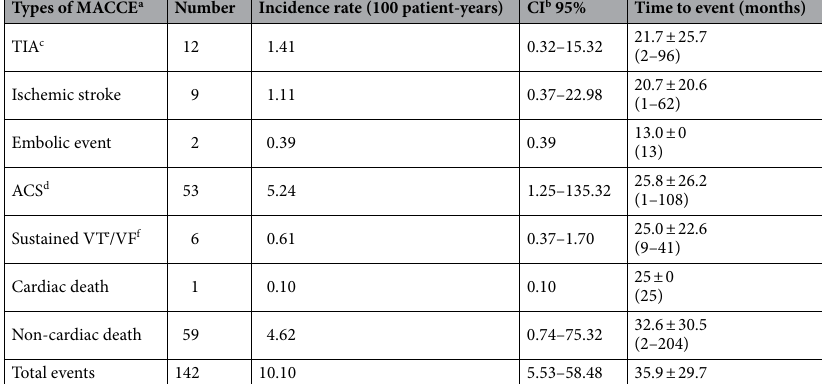
Table 2. Types and incidences of major adverse cardio/cerebrovascular events. Data are presented as mean ± SD or n. a MACCE major adverse cardio/cerebrovascular events. b CI confidence intervals. c TIA transient ischemic attack. d ACS acute coronary syndrome: including ST elevation myocardial infarction, non ST elevation myocardial infarction, and unstable angina. e VT , ventricular tachycardia. f VF ventricular